Question: Does the figure show an increasing or a decreasing trend?
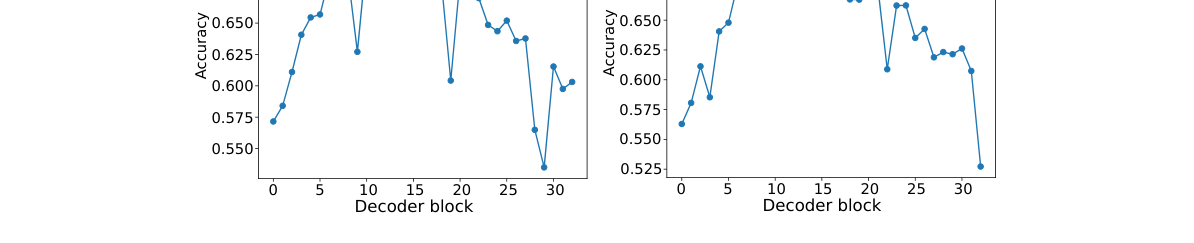
Answer: increasing